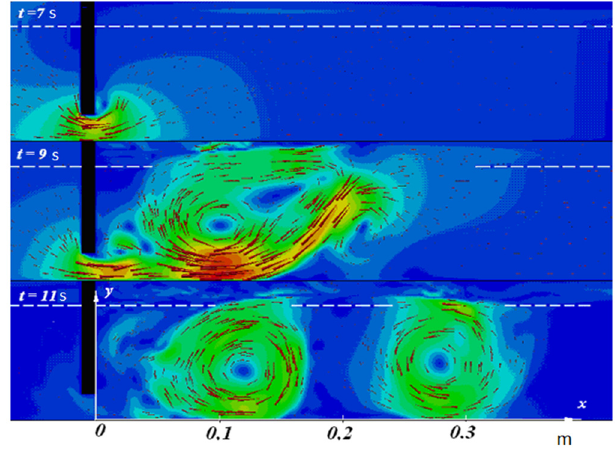
Figure 13. Visualization for various instants of time of velocity fields near thin barrier No. 2 (black color) in the case of transmission through it of a tsunami type wave: A/H = 0.07, parameter h /( H + A ) = 0.9. The dashed line corresponds to the unperturbed water flow level.